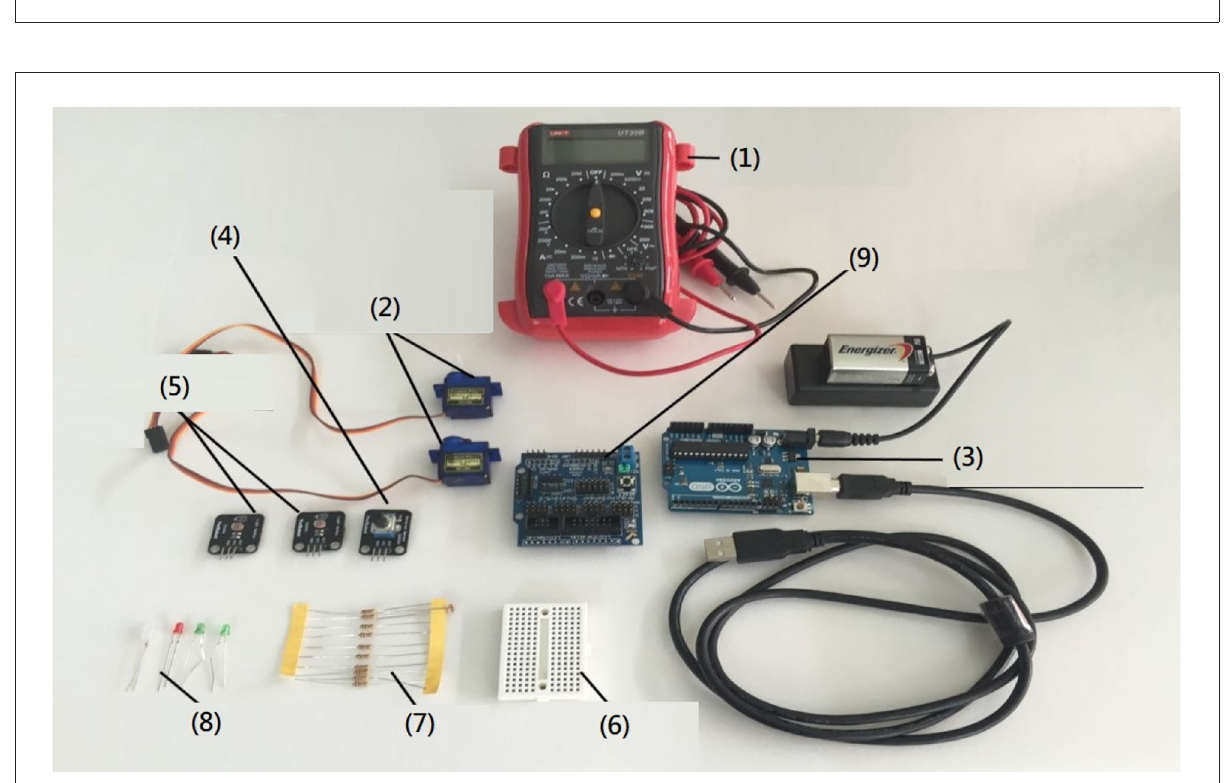
FIGURE2 Components and measuring